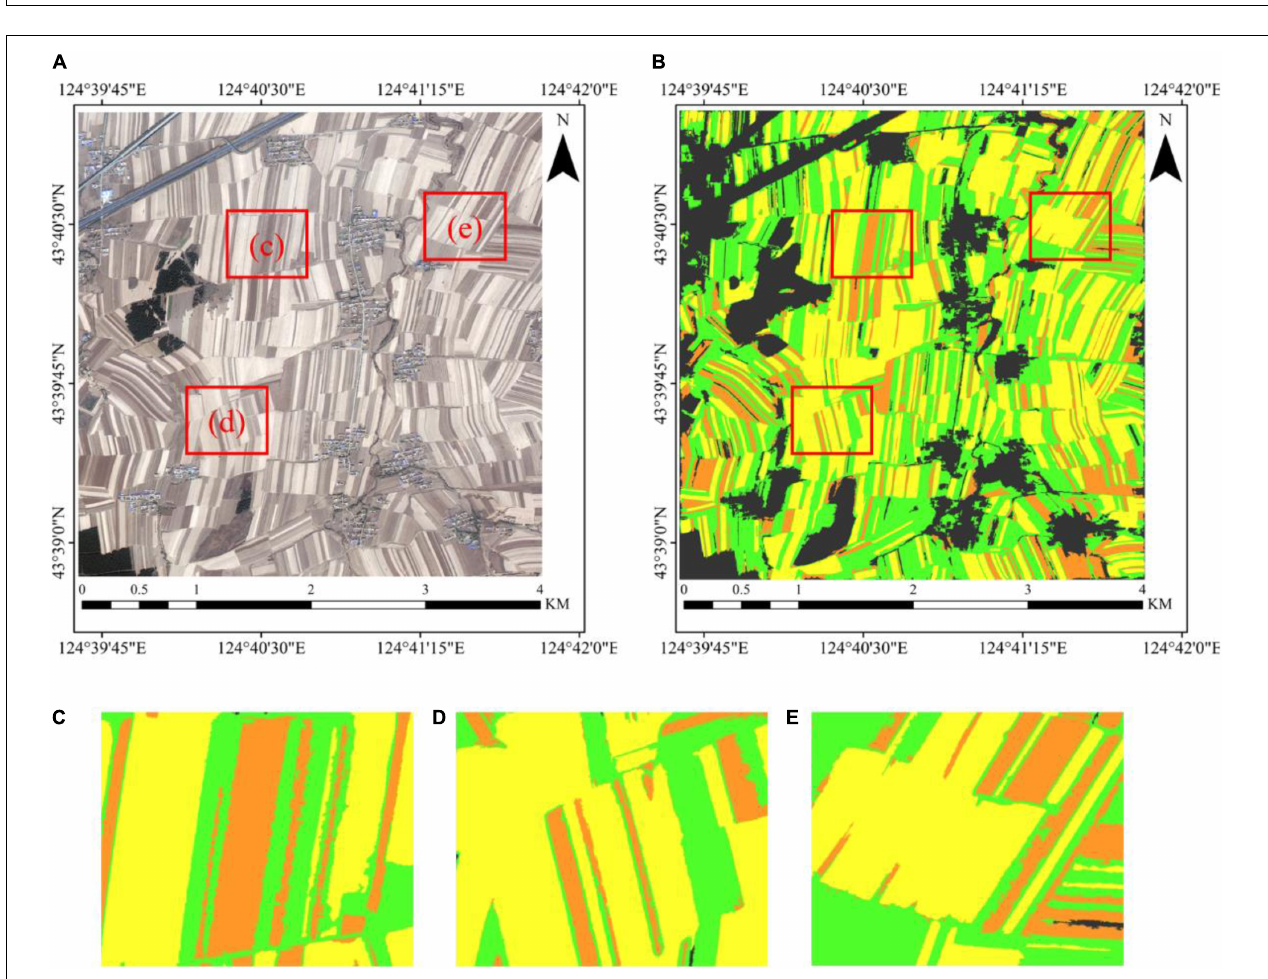
the same parameter settings on OID and DT1, “epochs” is 150, “batch_size” is 20, and the initial learning rate is 0.01. The classification results of the sub-images (650 pixel × 580 pixel) are displayed in Figure 9 . Images shown in Figure 9a are the original sub-images. Images shown in Figures